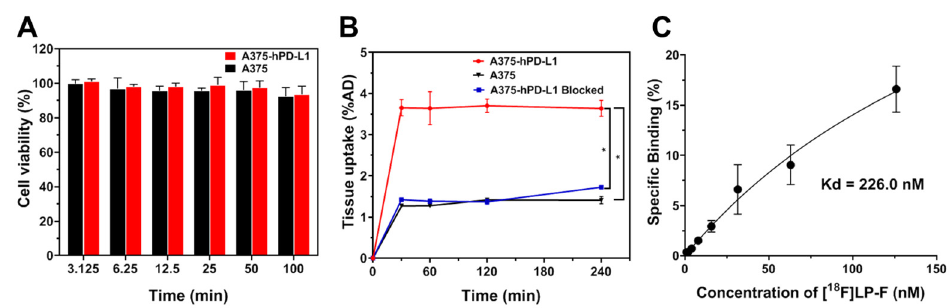
Figure 2. ( A ) Cell viability of PD-L1 - and PD-L1 + cells incubated with LP-F for 24 h. ( B ) The cellular uptake of [ 18 F] LP-F in A375 cells, A375-hPD-L1 cells and A375-hPD-L1 cells blocked by LP-F . ( C ) Specific binding of [ 18 F] LP-F to PD-L1 in PD-L1 + cell in vitro. * p < 0.05.